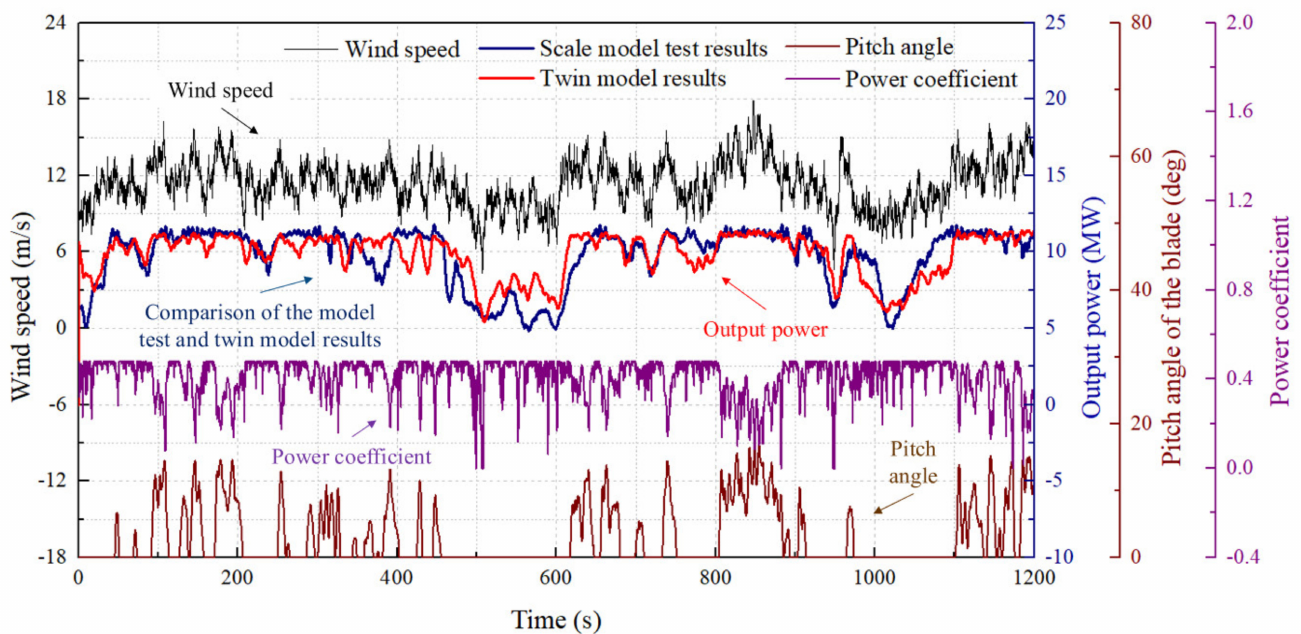
Figure 9. Comparison of the results of the reduced model test and the P-bOPM of a 10 MW FOWT for digital